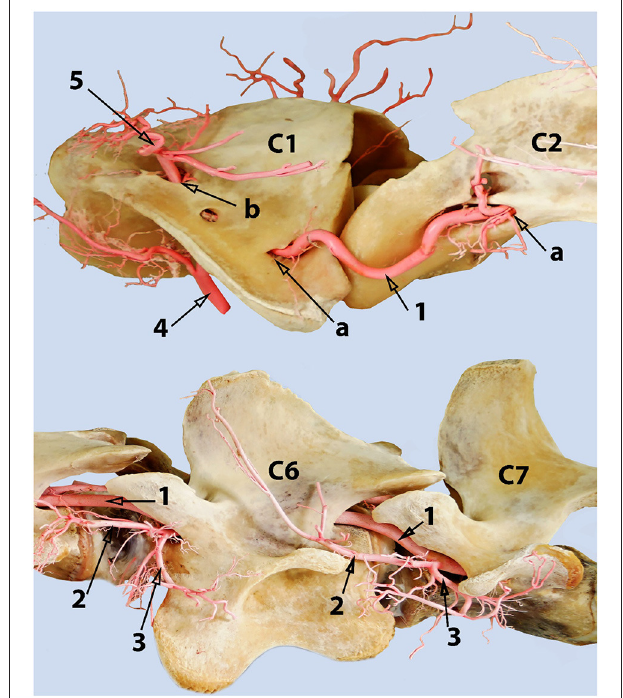
FIGURE 6 | A composite photograph (left lateral view) showing the cervical phase-route of the vertebral artery. Where 1, vertebral artery; 2, dorsal muscular branch of the vertebral artery; 3, ventral muscular branch of the vertebral artery, 4, occipital artery; 5, muscular branches arising from the anastomosis between the vertebral and the occipital arteries; a, transverse foramen; b, alar foramen. The vertebral artery anastomoses with the occipital artery inside the alar canal. The left transverse foramen of the 7th cervical vertebra is present, and the vertebral artery enters the vertebral canal through it in this